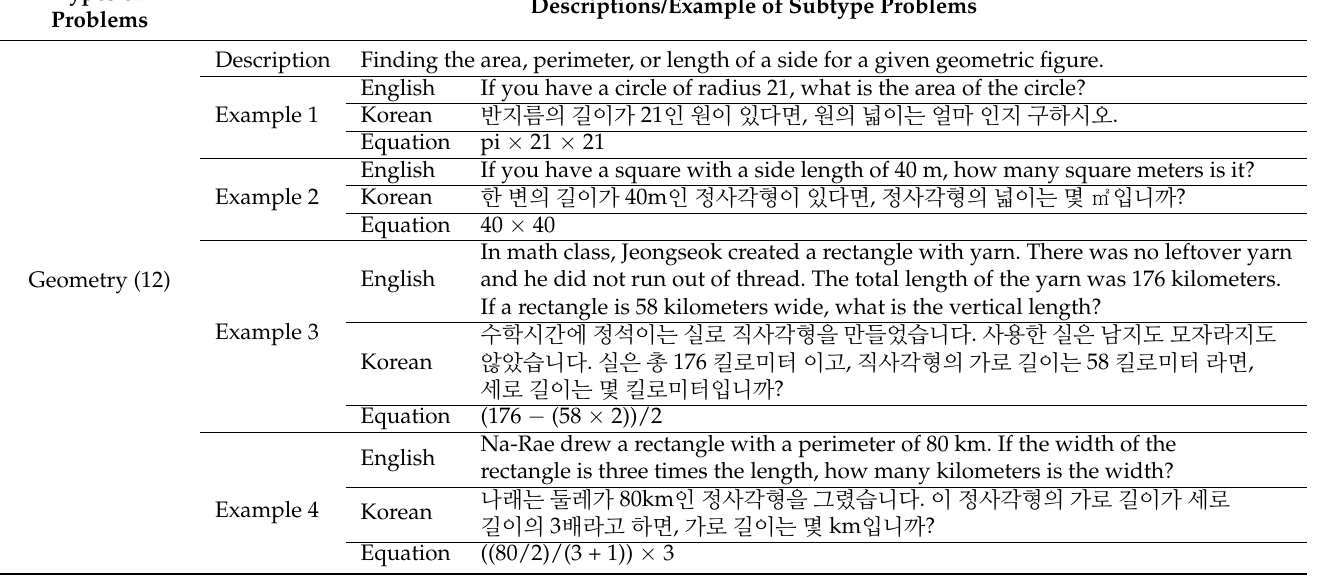
Table 4. Examples of the geometry